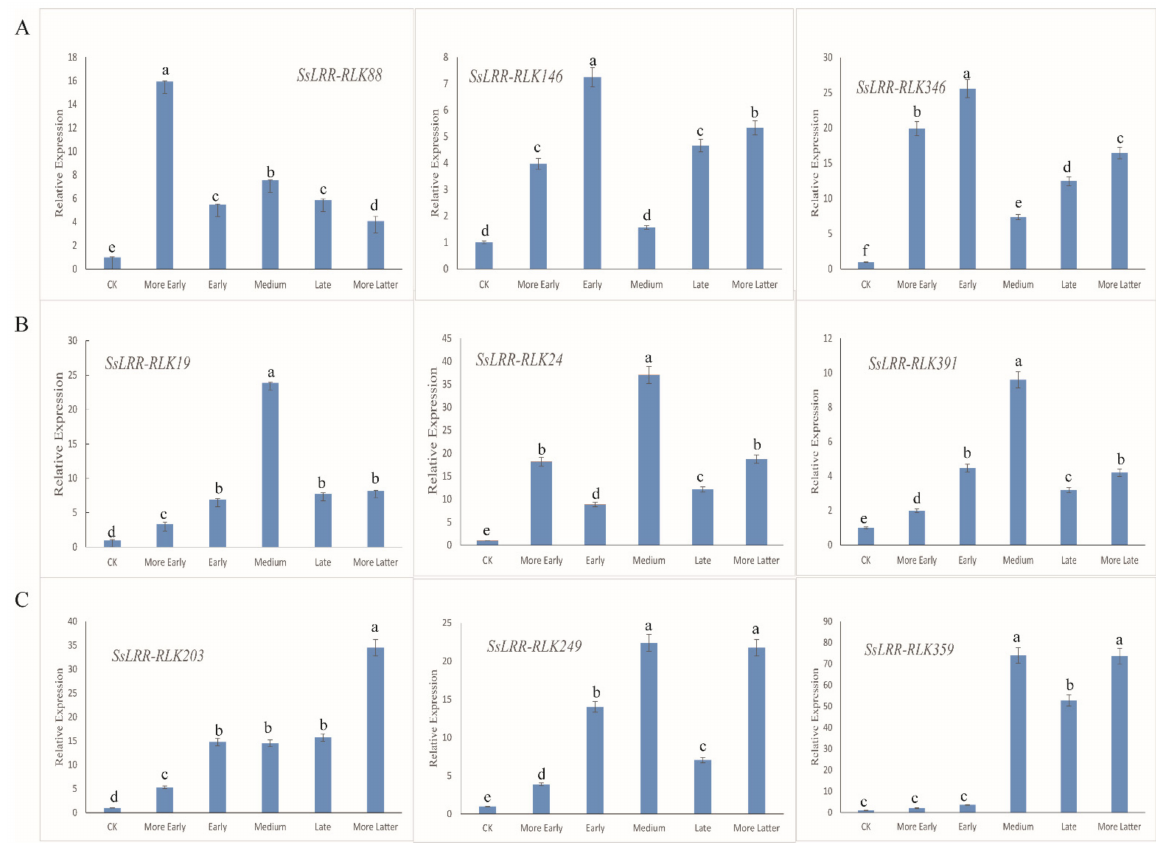
Figure 6. Relative expression levels of nine selected LRR-RLK genes were analyzed using quantitative real-time PCR (qRT-PCR). Among them, three obvious periods were discovered, namely the early, medium and late periods. ( A ) contains three highly expressed genes that respond to early period ( SsLRR-RLK88/146/346 ) that were identified. ( B ) contains three highly expressed genes that respond to medium period ( SsLRR-RLK19/24/391 ) that were identified. ( C ) contains three highly expressed genes that respond to late period ( SsLRR-RLK203/249/359 ) that were identified. X-axes show different stages and y-axes show relative expression level of each LRR-RLK gene. Bars represent the standard deviation (SD) ( n = 3) of three technical replicates. Different lowercase letters above the bars in the figure indicate a significant difference ( p < 0.05). Lowercase letters reflect the 5% significance level. As shown in the chart, a, b, c, d, e and f are different from each other, and they are all significantly different from each other. In addition, the same lowercase letter means no significantly